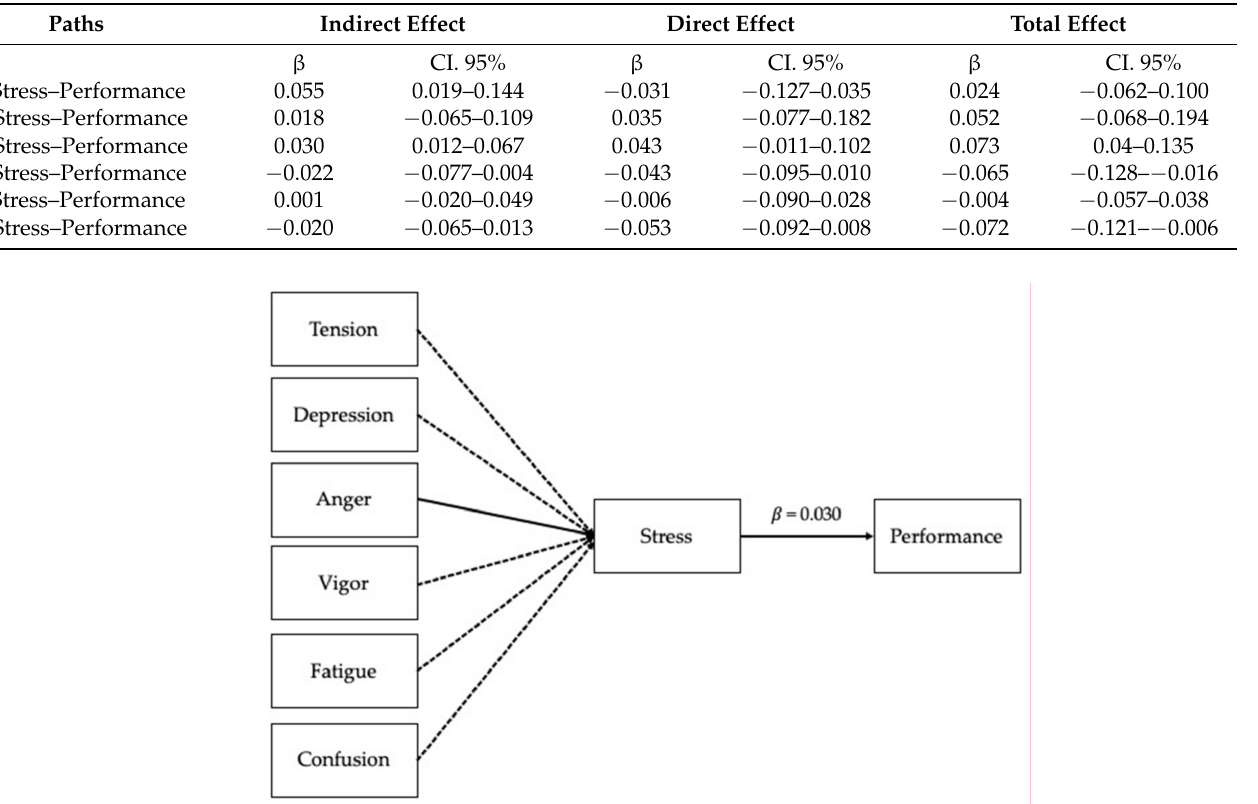
Table 5. Effects of mood states on performance through stress (standardized β ).